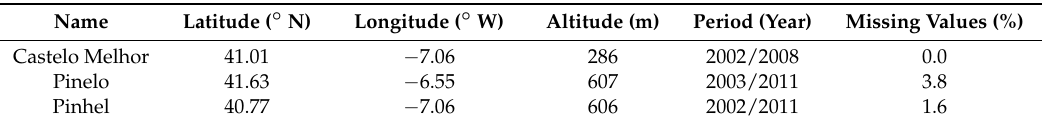
Table 1. Characteristics of the weather stations where the data used in this study were measured, including the code, name, altitude and geographical